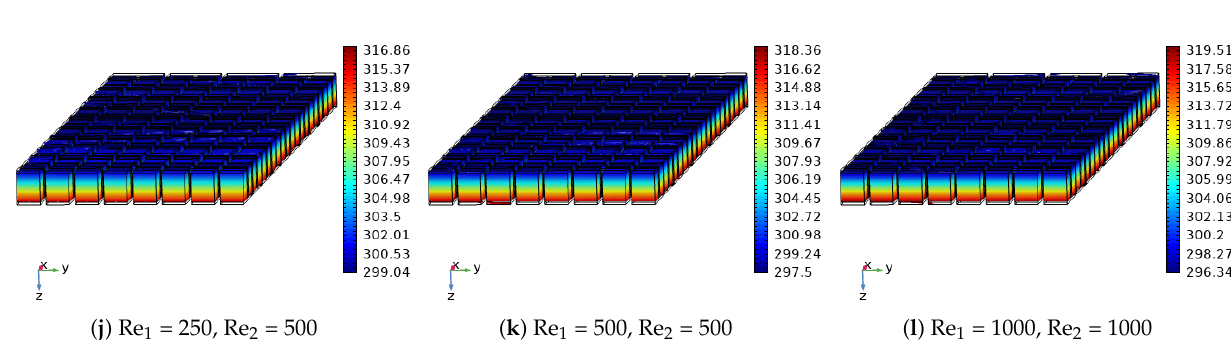
Figure 5. Effects of different jet stream Reynolds number combinations on the variation of streamlines within the channels, electric potential and temperature distributions within the TEG module ( (r 1 ,r 2 ) = (1,1), z h = 3w s , φ = 0.02).